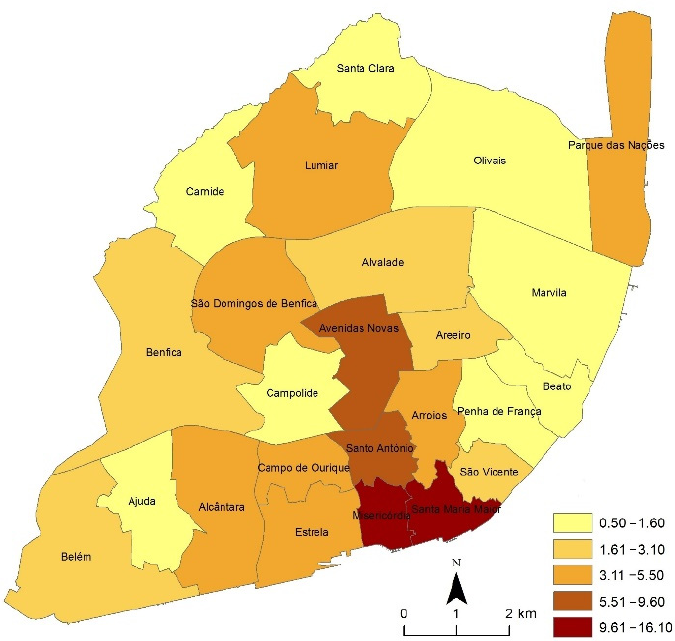
Figure 2. Spatial distribution of the sample in the municipality of Lisbon (%).